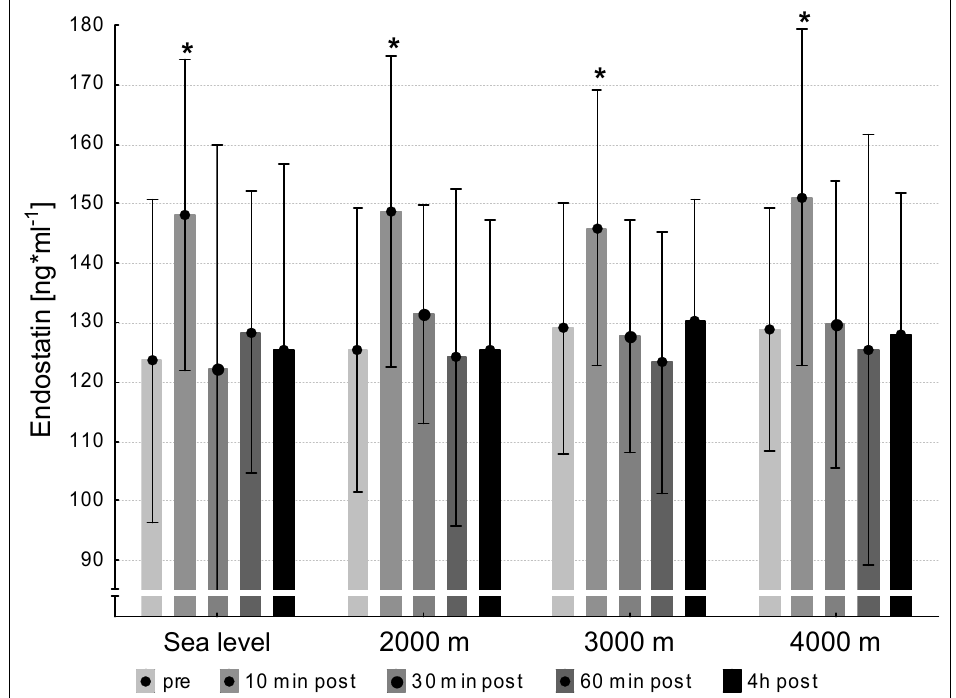
Figure 5. Endostatin concentration at the five measurement time points (pre, 10 min post, 30 min post, 60 min post, 240 min post exercise) during the different ambient conditions (sea level, 2000 m, 3000 m, 4000 m). Mean ± standard deviation. * p < 0.05 to pre.